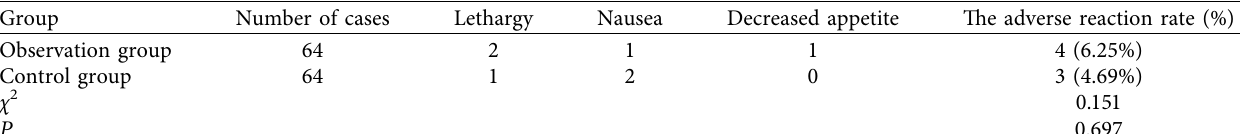
Table 5: Comparison of adverse conditions between the two groups ( n ,